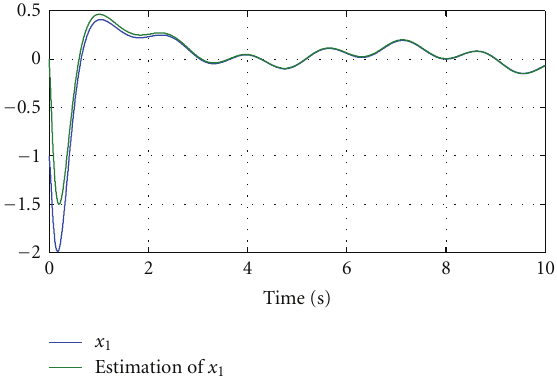
Figure 7: System outputs y 1 and y 2 for Example